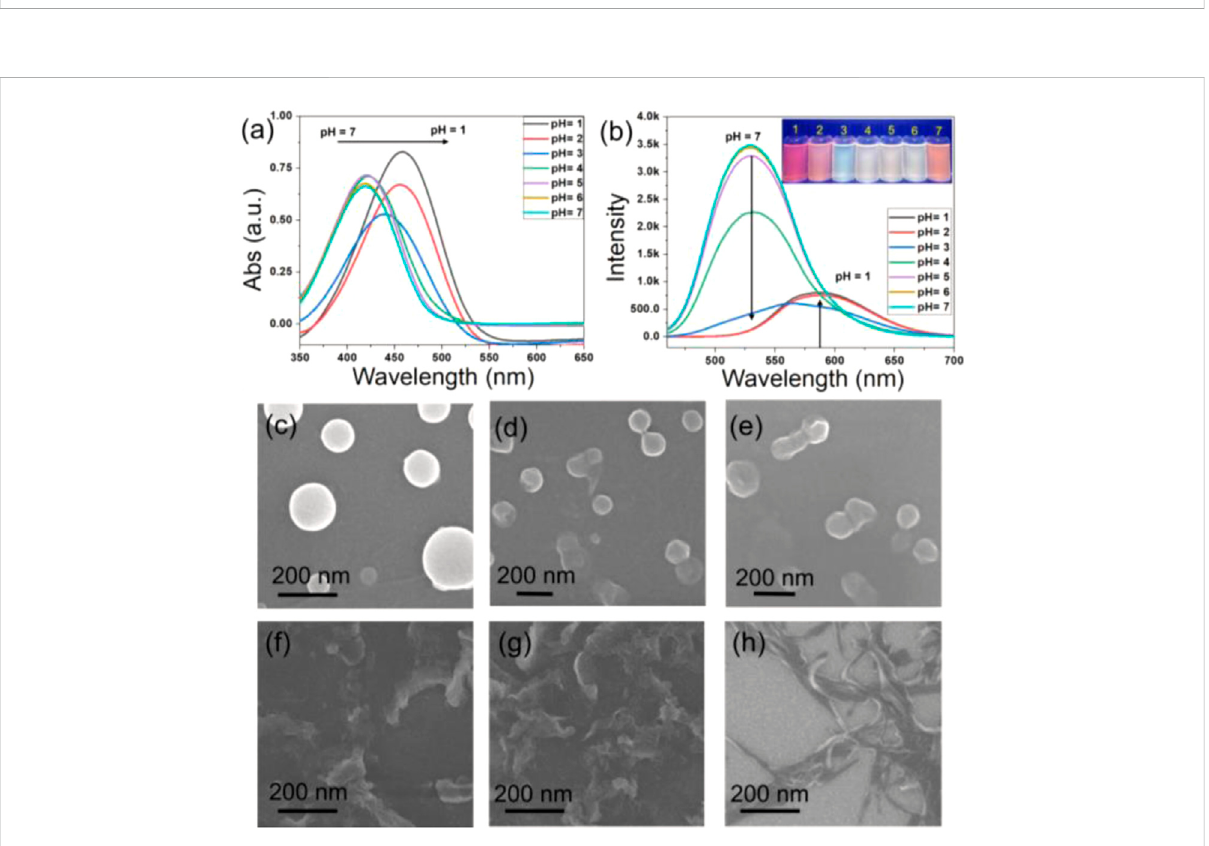
FIGURE 2 (A) absorption and (B) emission spectra of TPPA (0.4 mM, 4 ml) in 10 ml THF/water mixture (THF/H 2 O = 2:8) with different pH. SEM images of TPPA self-assembly in THF/water mixture (THF/H 2 O = 2:8) with different pH (C) pH = 1, (D) pH = 2, (E) pH = 3, (F) pH = 5, (G) pH = 6, (H) pH =